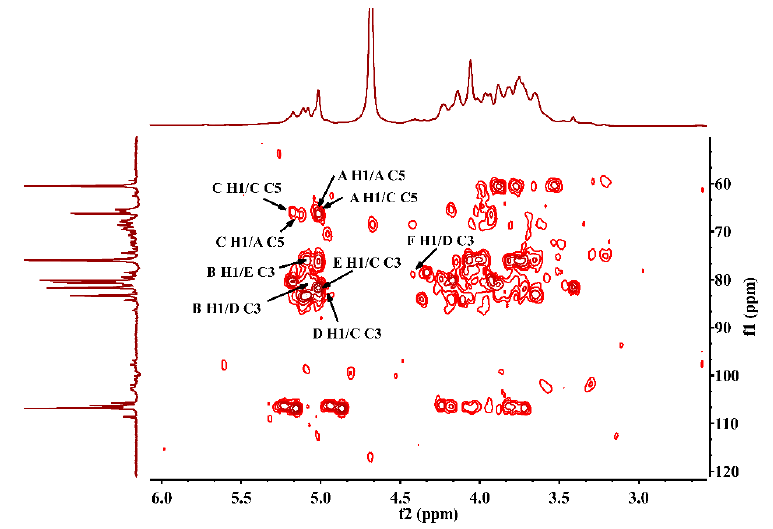
Figure 5. HMBC spectrum of JC-PS1.